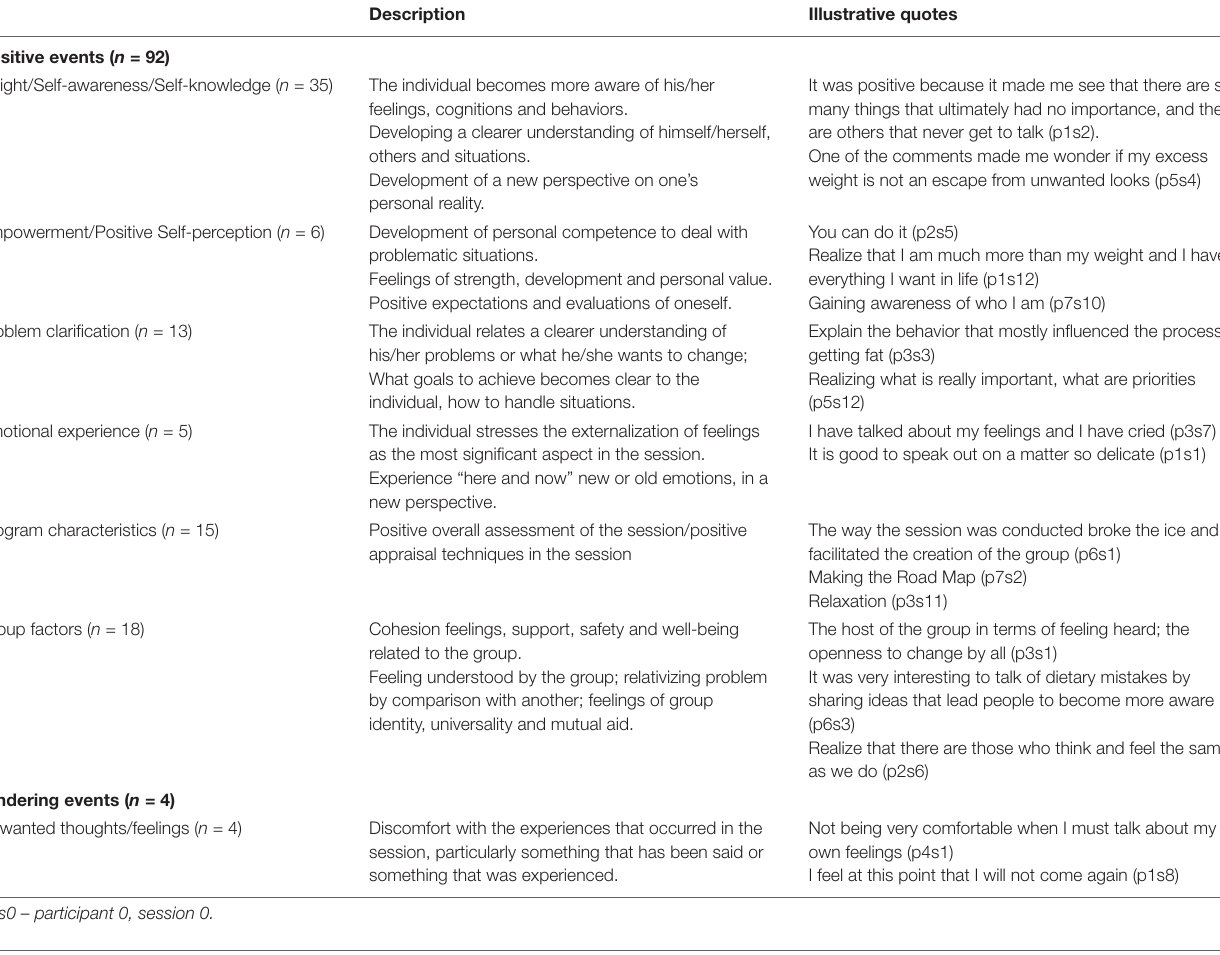
TABLE 3 | Helpful aspects of therapy: description and illustrative quotes of significant positive and hindering events.